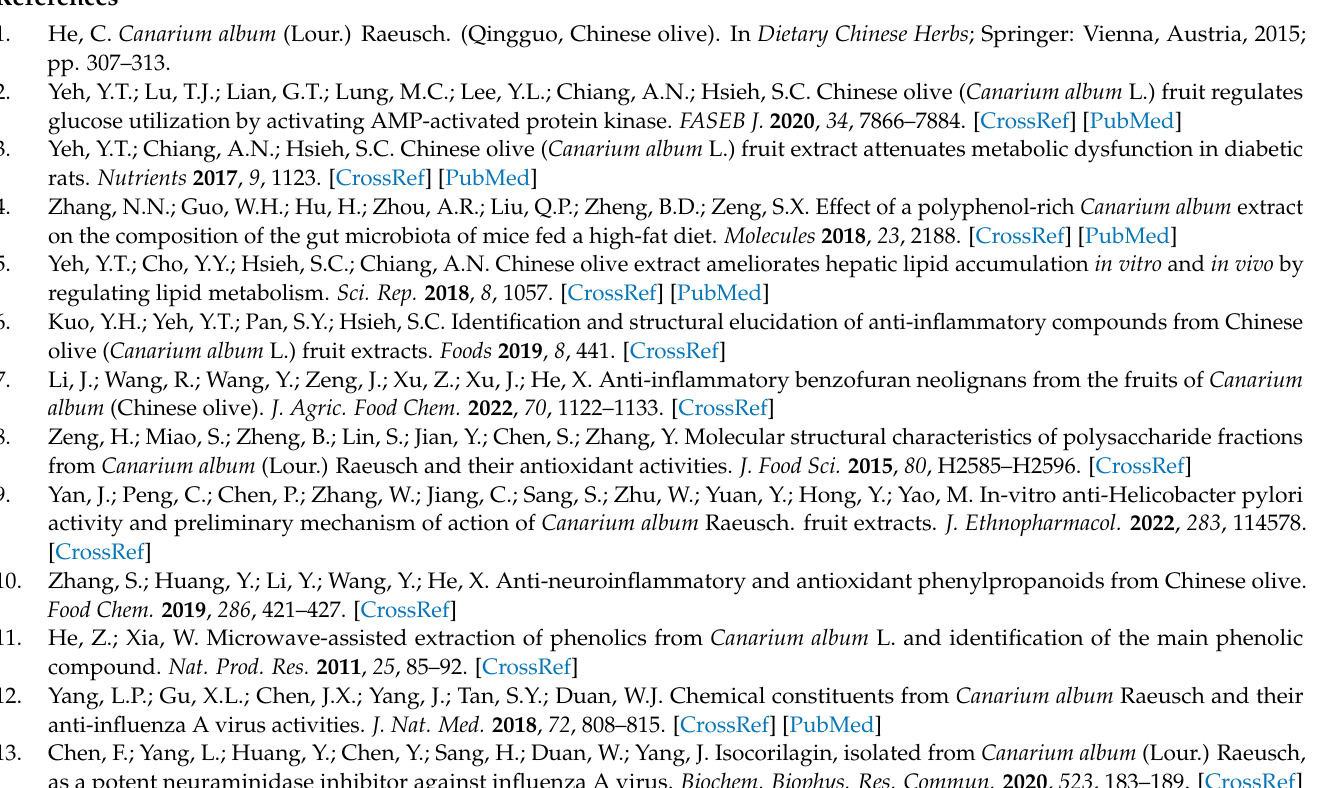
Figure S1: Chromatograms for the LC-MS results of fruits of four Canarium album